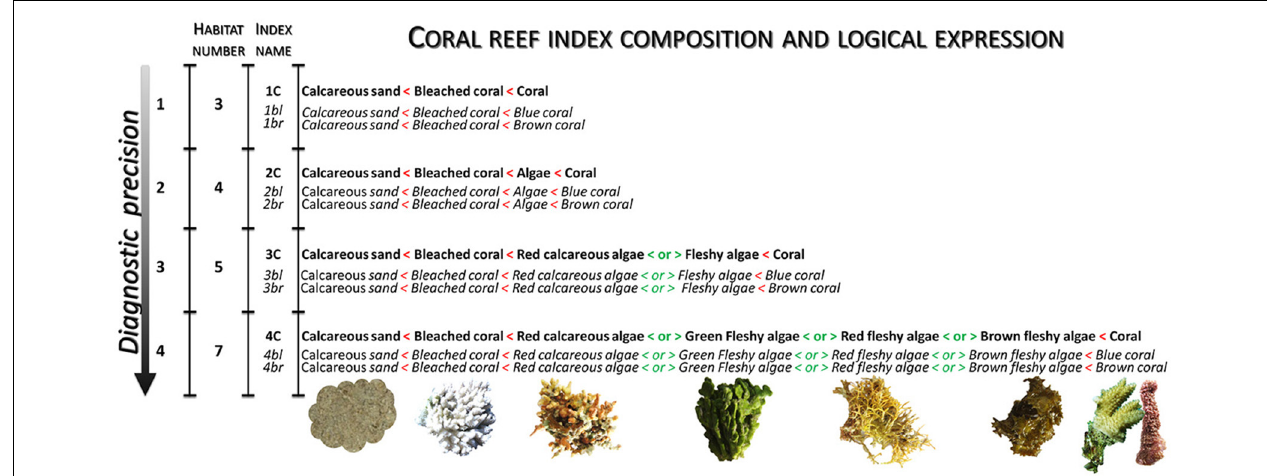
FIGURE 6 | Design of the 12 coral reef indices defined by their habitat composition and logical expressions linking up to the 11 coral reef habitats, index names, number of habitats involved, and level of the diagnostic